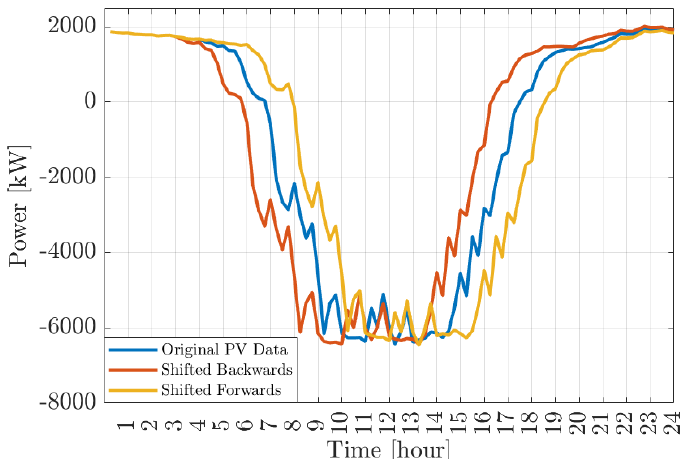
Figure 10. Dispatch plan with shifted PV generation time series forwards and backwards.